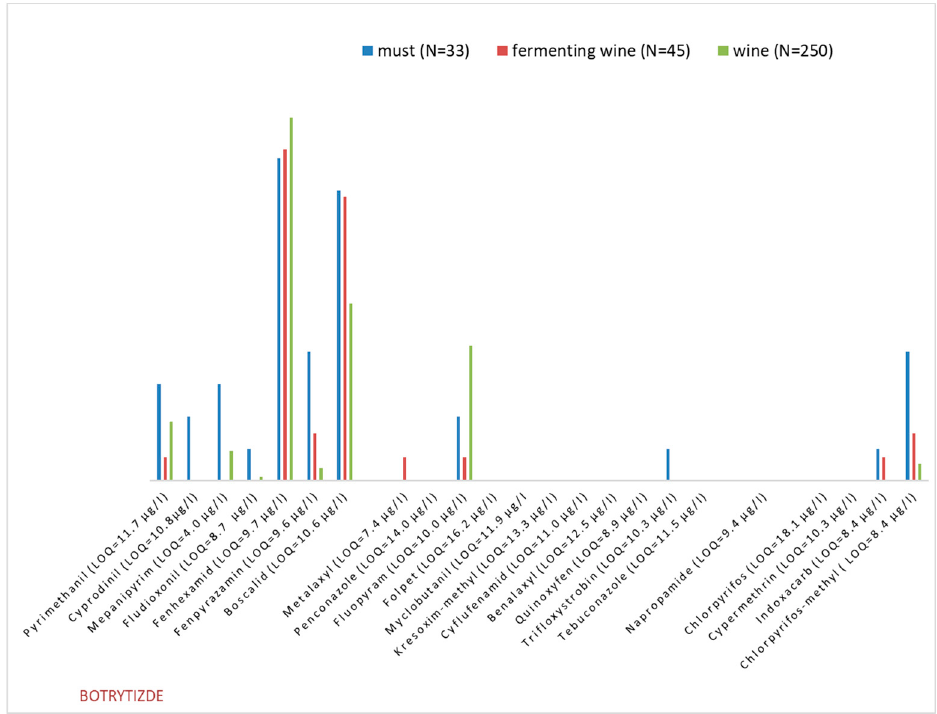
Figure 2. Percentage of samples with quantifiable concentrations of residues: For identification of the samples Tables S1 and S2.